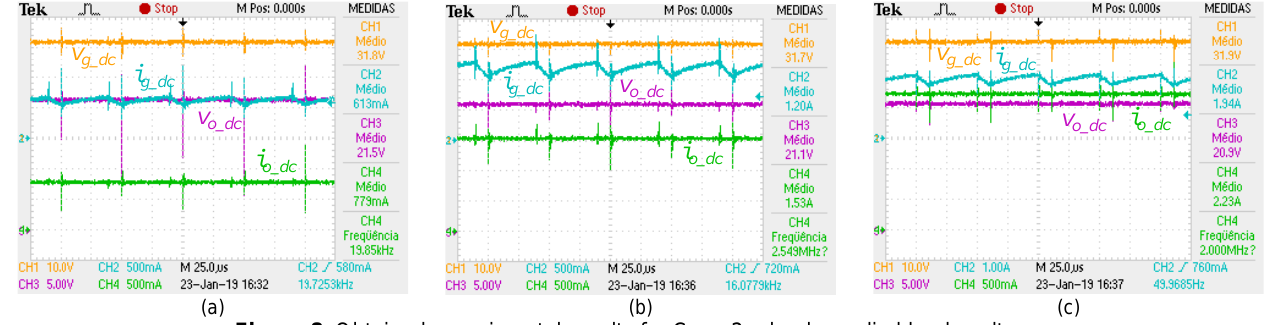
Figure 8. Obtained experimental results for Case 2 – load supplied by dc voltage: